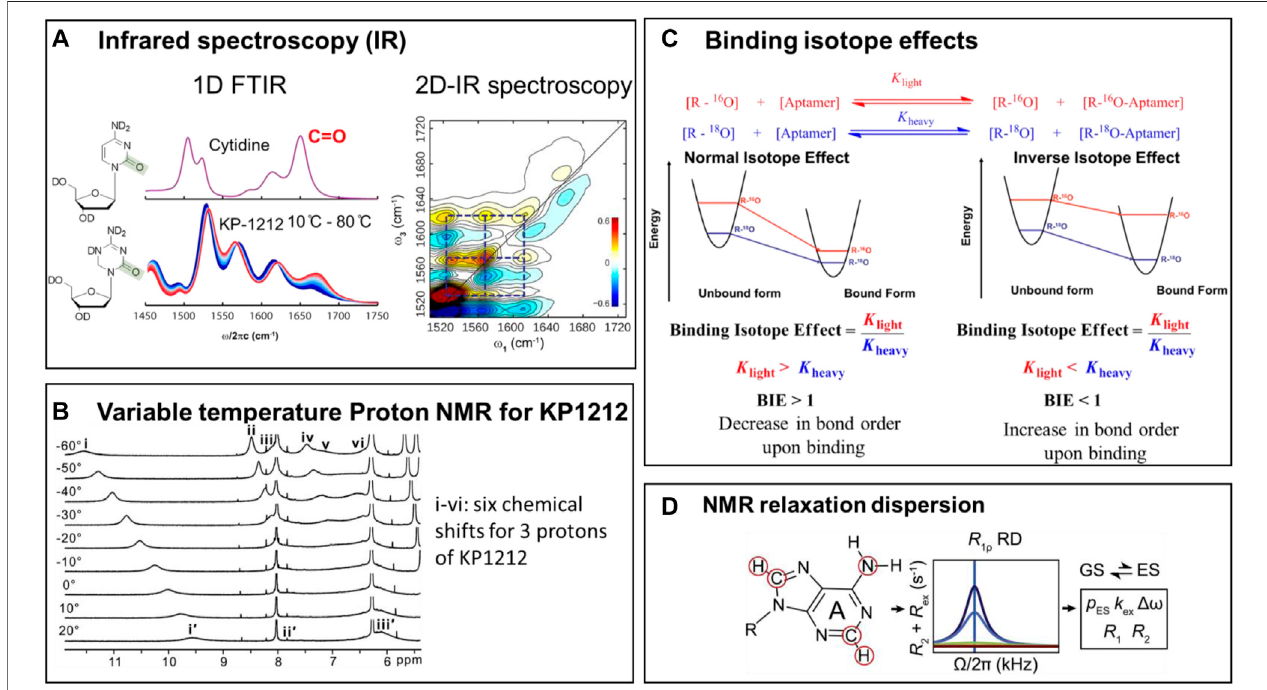
FIGURE 6 | Methods for studying tautomerism in nucleoside analogs and nucleic acids. (A) Left side: The Fourier-Transform Infrared (FTIR) spectra for 2 ′ - deoxycytidine (dC) at room temperature, and the temperature dependence of vibrational frequencies in the. FTIR spectra for KP1212. Right side: The 2-Dimensional Infrared (2D-IR) spectroscopic data for KP1212, in aqueous solution at room temperature (Li et al., 2014). (B) Variable temperature 1H-NMR data for KP1212 (Li et al., 2014). Figures 6A,B are adapted from (Li et al., 2014). (C) Binding isotope effects combined with Density Functional theory (DFT) calculations used in the characterization of the tautomeric form of OxyTPP bound to the TPP riboswitch (Singh et al., 2015). Reprinted (adapted) with permission from (Singh et al., 2014) Copyright © 2014, American Chemical Society. (D) NMR relaxation dispersion methods used to identify and quantitate rare tautomers in a G duplexes in W-C conformations (Rangadurai et al., 2019). Figure courtesy of Hashim Al-Hashimi Duke